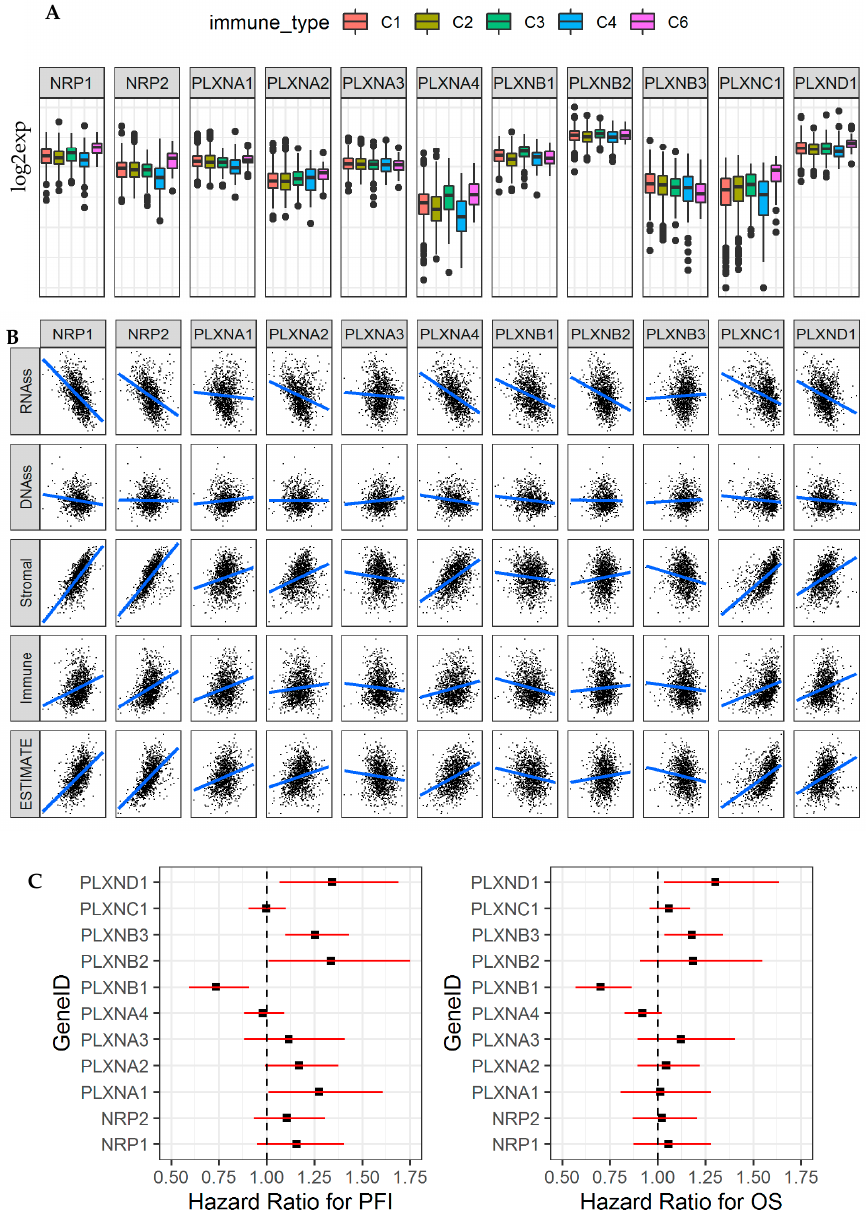
Figure 7. NRPs and PLXNs are associated with immune subtypes, tumor infiltrates, and patient survival in breast cancer (BRCA). ( A ). Association of NRP and PLXN gene expression with immune infiltrate subtypes in breast cancer tested with ANOVA ( p < 0.0001). C1: wound healing, C2: INF-r dominant, C3: inflammatory, C4: lymphocyte depleted, C5: immunologically quiet, and C6: TGF β -dominant. p < 1/(11 genes × 5 subtypes) = 0.018 as significance. ( B ). Correlation matrixes between NRP and PLXN gene expression and RNAss, DNAss, stromal score, immune score, and estimate score. Spearman correlation tests were used for testing. p < 1/(11 genes × 5 scores) = 0.018 as significance. ( C ). The forest plots with the hazard ratios (HR) and 95% confidence intervals for overall survival (OS) and progression free interval (PFI) to show survival advantage (HR < 1) and disadvantage (HR > 1) with increased gene expression of NRPs and PLXNs in BRCA. Univariate Cox proportional hazard regression models were used for the association tests. p < 0.05 was considered as